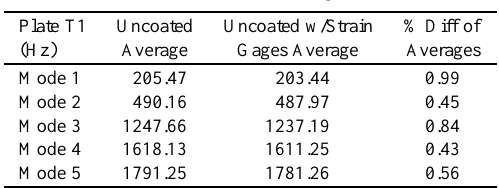
Table 4 Resonant frequencies from laser vibrometer for plate T1